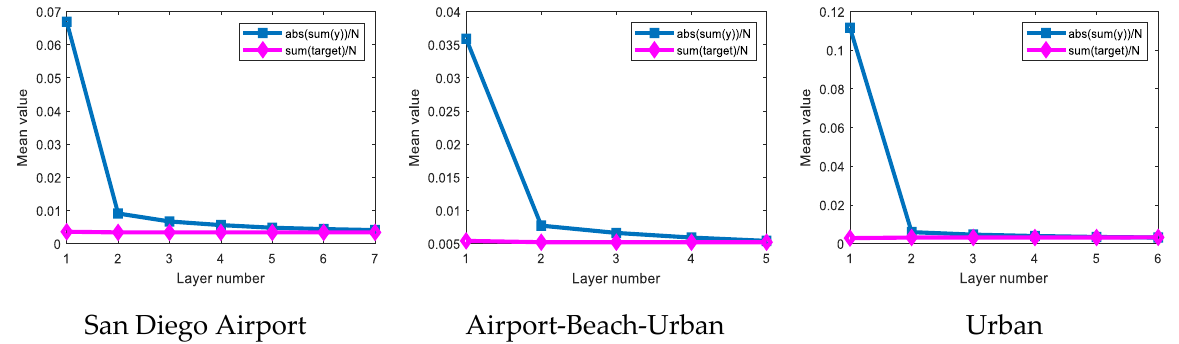
Figure 10. Output mean value of different layers on three hyperspectral data.